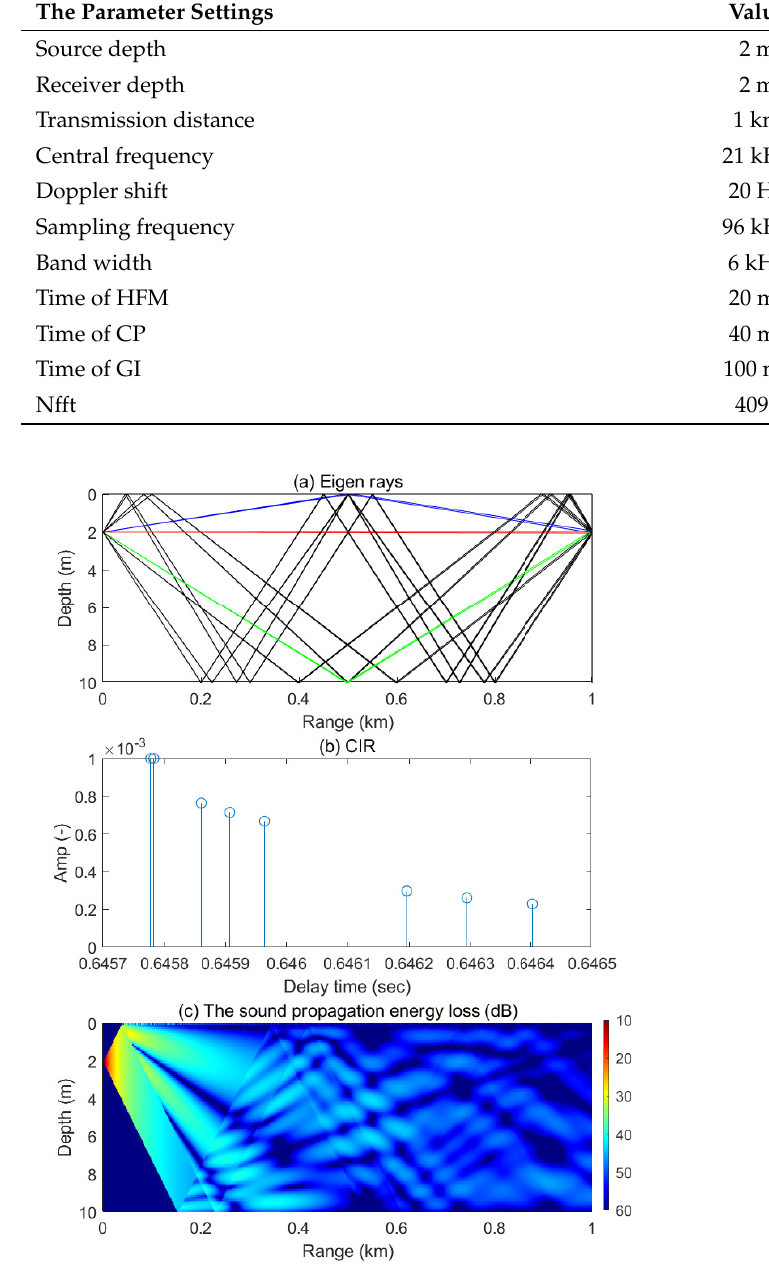
Table 3. The parameter settings in the simulations.